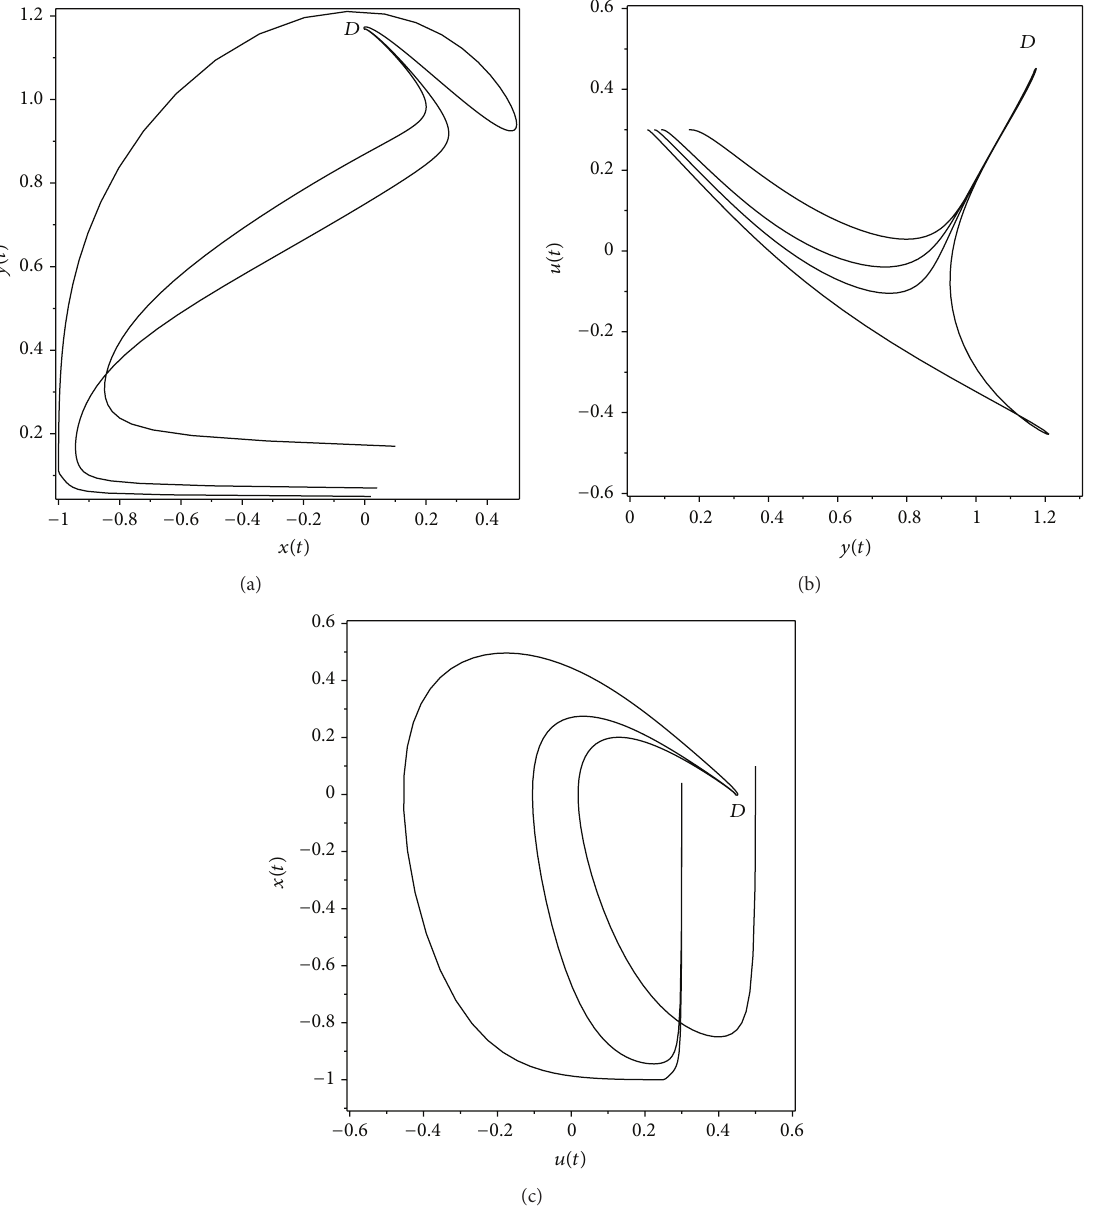
Figure 3: From (a) to (c), the projections of the phase-space trajectories on the 𝑦 − 𝑥 , 𝑢 − 𝑦 , and 𝑥 − 𝑢 planes with 𝜉 = 0.92 and 𝛼 = 1.5 . The trajectories are attracted by the point 𝐷